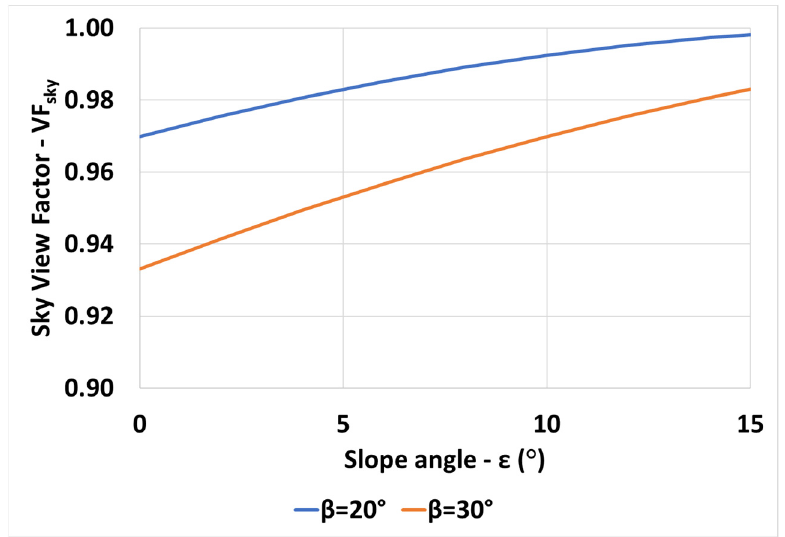
Figure 14. Variation of the sky factor of a single collector, 𝐻 = 2 m , on an inclined plane, 𝜀 .